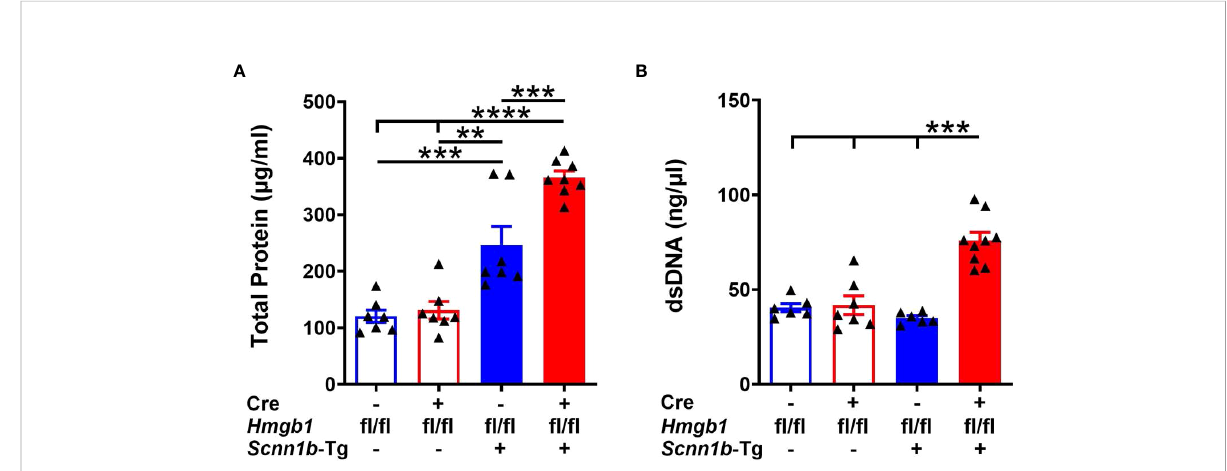
FIGURE 4 Airway epithelial cell-speci fi c HMGB1-de fi cient mice exhibit elevated BALF protein and dsDNA contents in Tg+ mice. The total protein contents (µg/ml) (A) and dsDNA contents (ng/µl) (B) in cell-free BALF from WT mice (with Cre - or Cre + status) and Tg+ mice (with Cre - or Cre + status). Error bars represent Mean ± SEM. One-way ANOVA followed by Tukey ’ s post hoc test was used for the statistical analysis. Sample size n=6-9/ group. ** p < 0.01, *** p < 0.001, **** p < 0.0001.